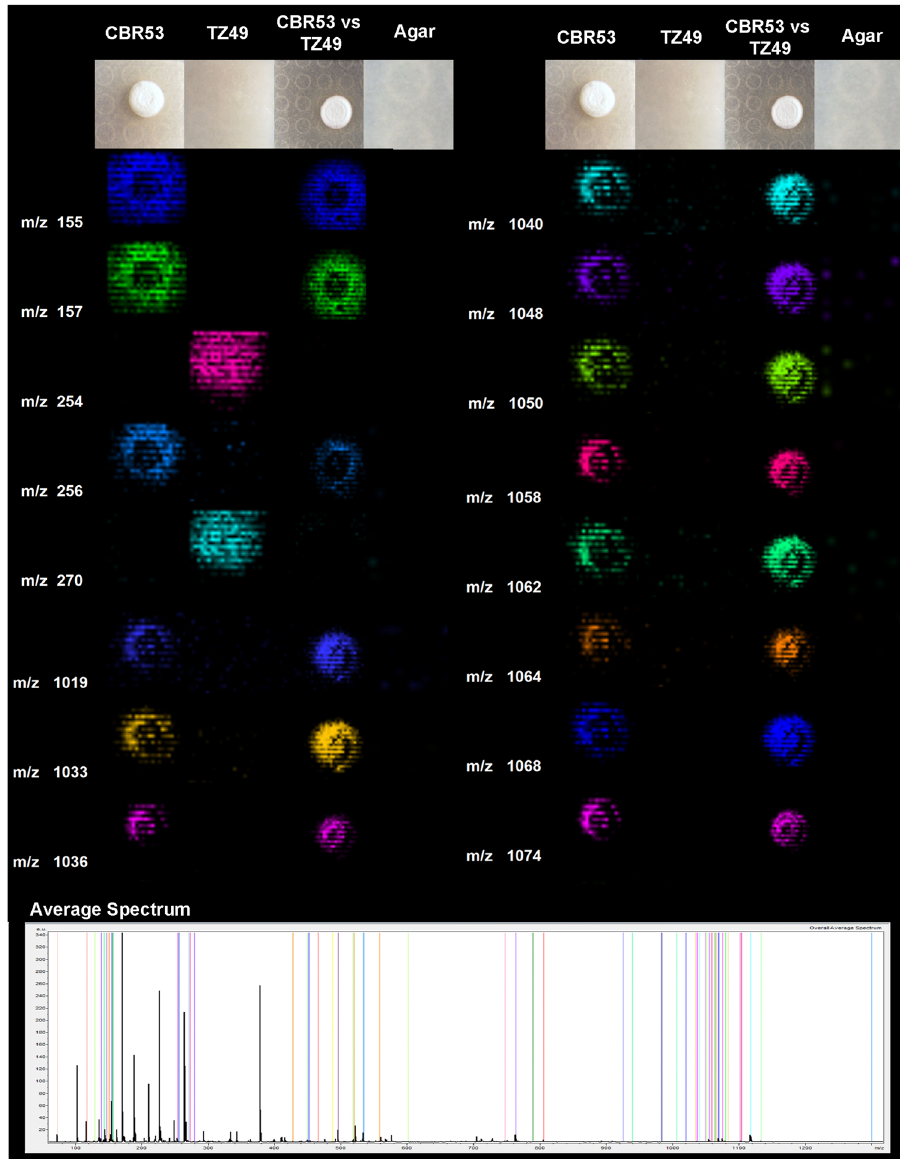
Figure 1. MALDI-TOF imaging mass spectrometry of microbial interactions between Streptomyces CBR53 and pathogenic fungi Escovopsis TZ49. Representative ions observed for the microbial interaction are presented as columns, first column show mass to charge ratio, second to fifth columns display false-colored images of the spatial distribution of the ions observed around: Streptomyces sp. (CBR53); Escovopsis sp. (TZ49); Streptomyces sp. vs Escovopsis sp. (CBR53vsTZ49); and SFM Agar. Average mass spectrum highlighting all the selected ions is shown at the